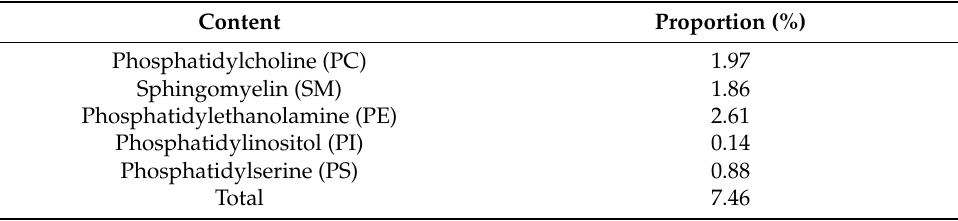
Table 1. The proportion of phospholipids in milk fat globule